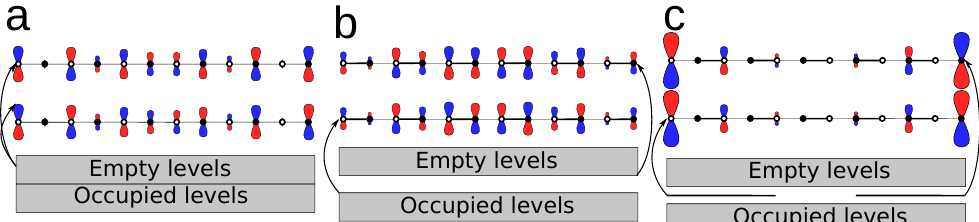
Figure 2. A scheme of the energy levels and HOMO/LUMO coefficients for: ( a ) the metallic (delo- calized) case; ( b ) the trivial (main resonant form) case; and ( c ) the topological case (resonant form with